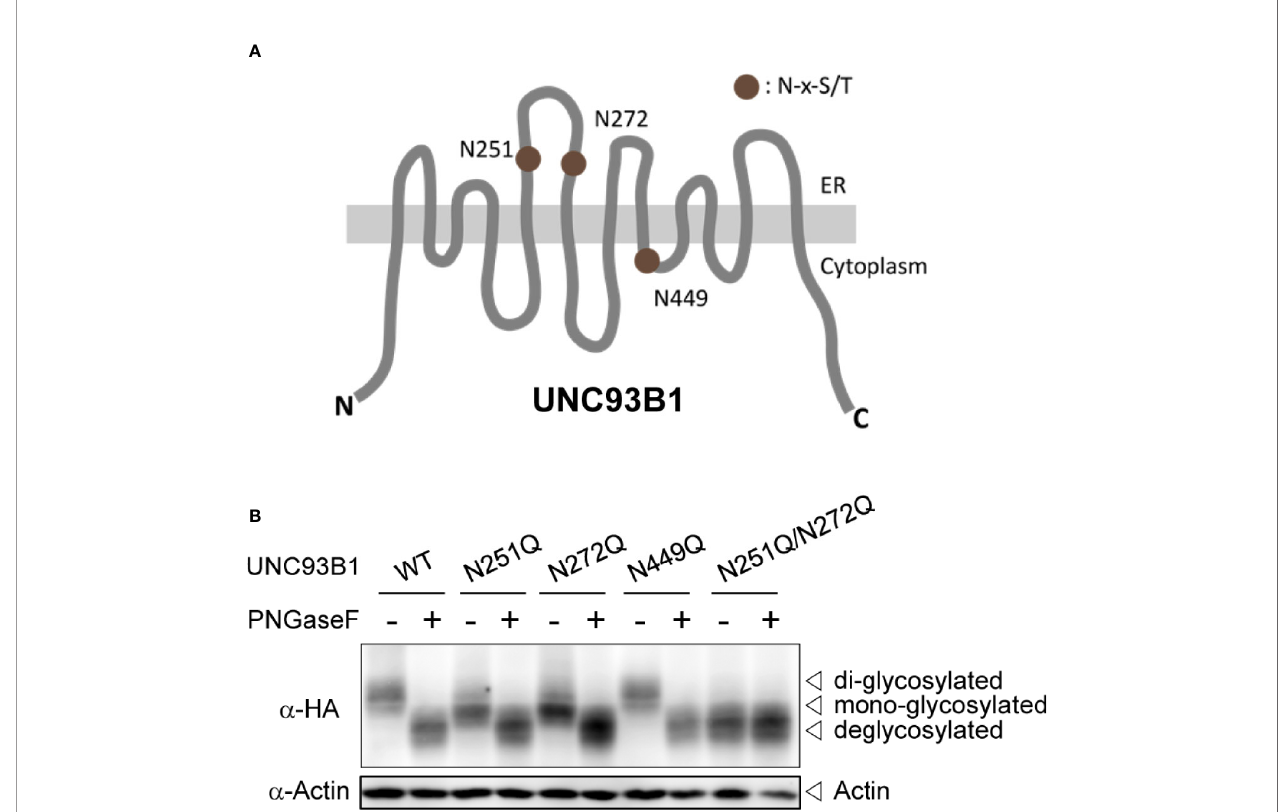
FIGURE 1 | UNC93B1 is glycosylated at N251 and N272 residues. (A) Schematic diagram of UNC93B1. N-glycosylation sites predicted by the consensus amino acid sequence motif, Asn-x-Ser/Thr (NxS/T) are depicted. (B) HEK293T cell lysates expressing wild type or mutant UNC93B1-HA were treated with or without PNGase F. UNC93B1- HA and actin were detected by immunoblotting with anti-HA antibody and anti-actin antibody,